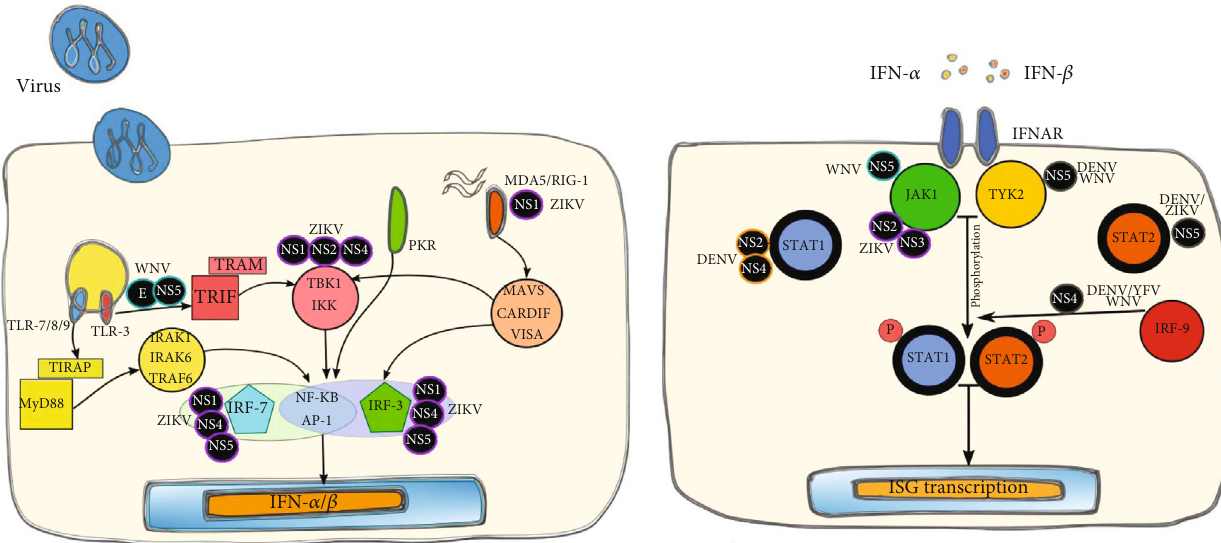
Figure 6: Inhibition of the IFN-I pathway by fl aviviruses. Di ff erent viral proteins are involved in the modulation of the IFN-I activation pathway. Circular boxes in black background represent the viral protein involved in the pathway inhibition. Abbreviations: nonstructural protein (NS) 1, 2, 3, 4, and 5; E: envelope protein.